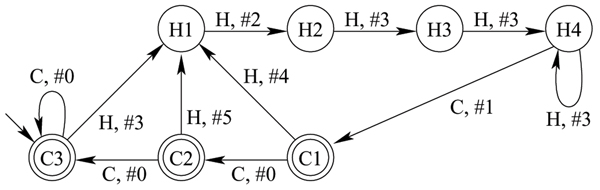
Predictor finite state machine. Double circles represent accept states. The arrow leading into state C3 indicates that it is an initial state. Each transition is labeled with the type of structure it corresponds to: helix (H) or coil (C), and a label (#i) indicating which features correspond to this transition in Table 4.